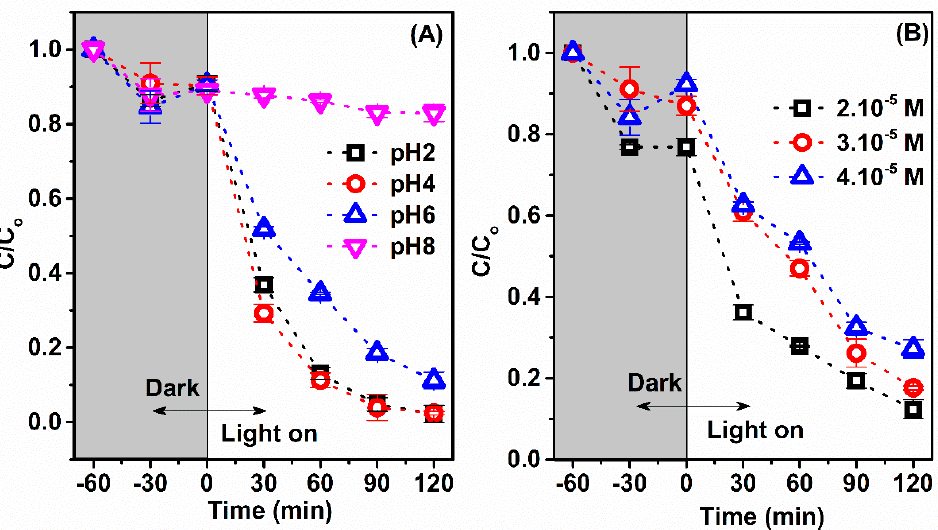
Figure 8. Effect of pH solution ( A ) and initial concentration dye ( B ) on Rhodamine removal efficiency over 15% Fe/Ti-MOFs.